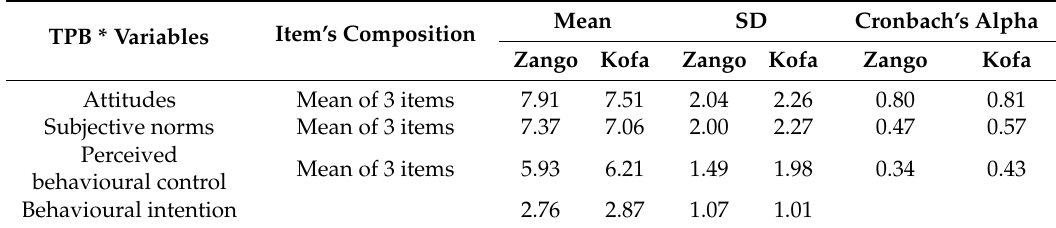
Table 4. Descriptive statistics of TPB components for climate change adaptation behaviour (Zango—n = 86; Kofa—n = 68).